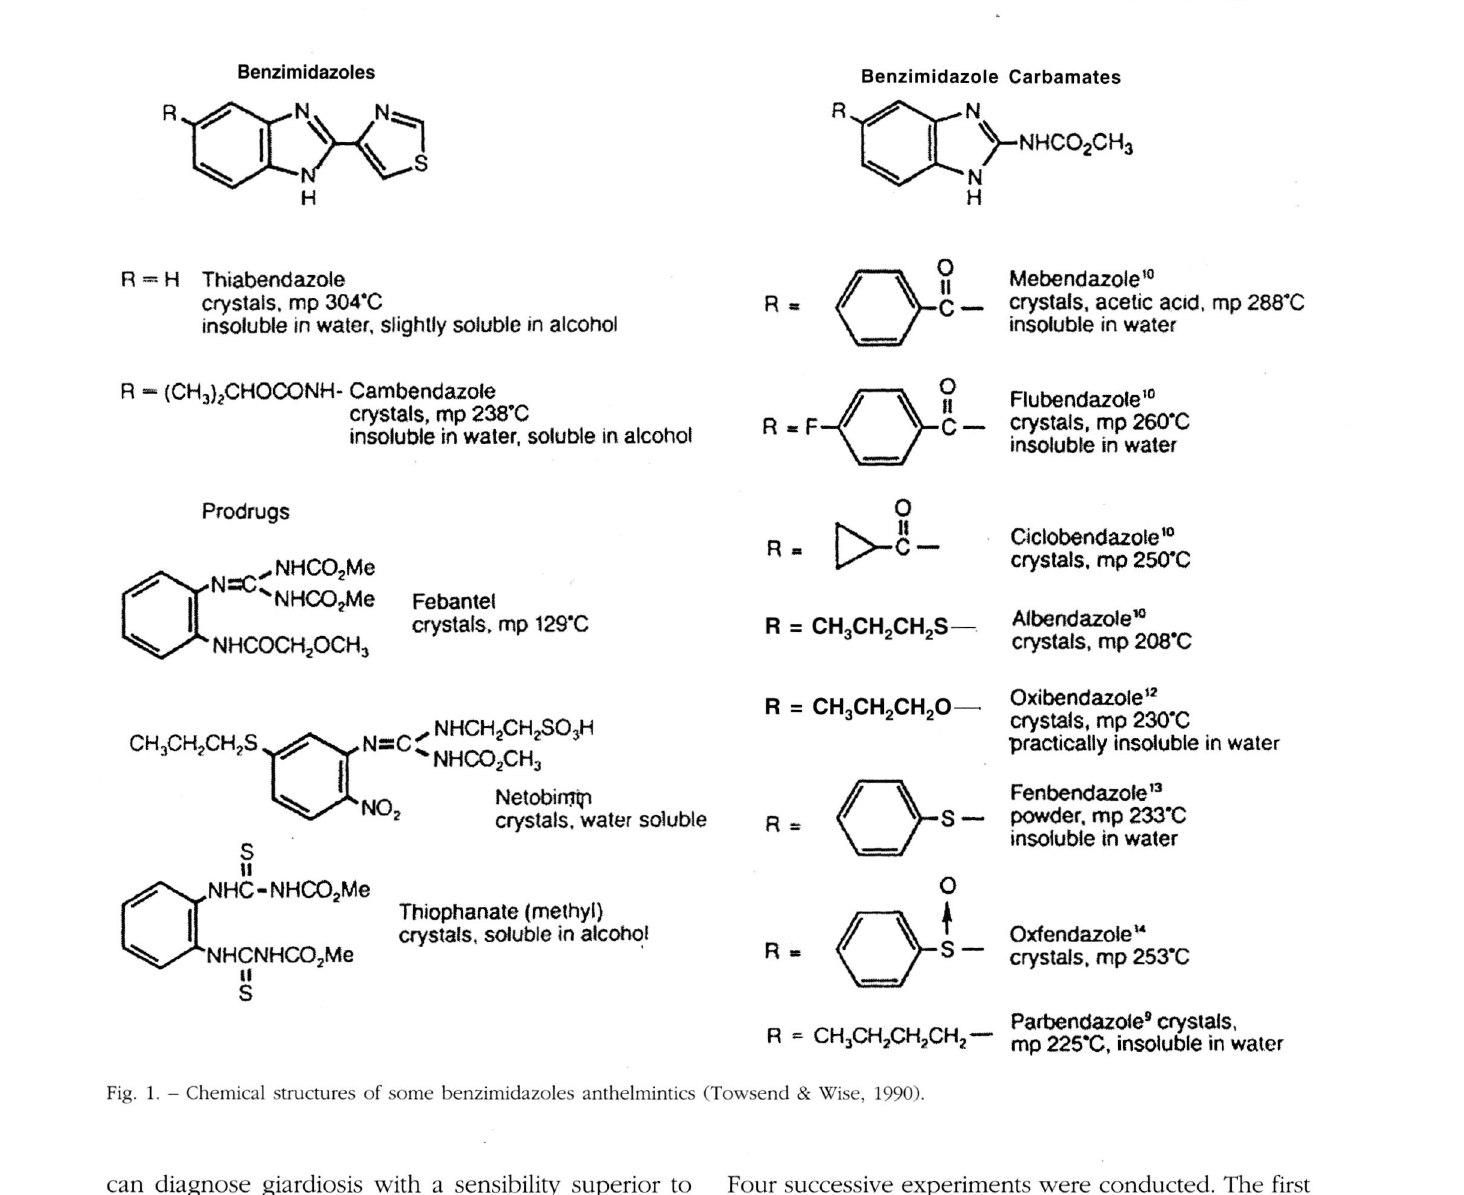
can diagnose giardiosis with a sensibility superior to 95 % (Barr et al., 1992; Leib & Zajac, 1999). The floating technique, using a high density liquid, especially suits protozoan cysts research, since these latter are not very dense (Barr et al., 1992). Magnesium sulfate with 1.28 density up to 25° C (35 g of magne sium sulfate per 100 ml of water) was held. Cysts number quantification is given with an order of size.